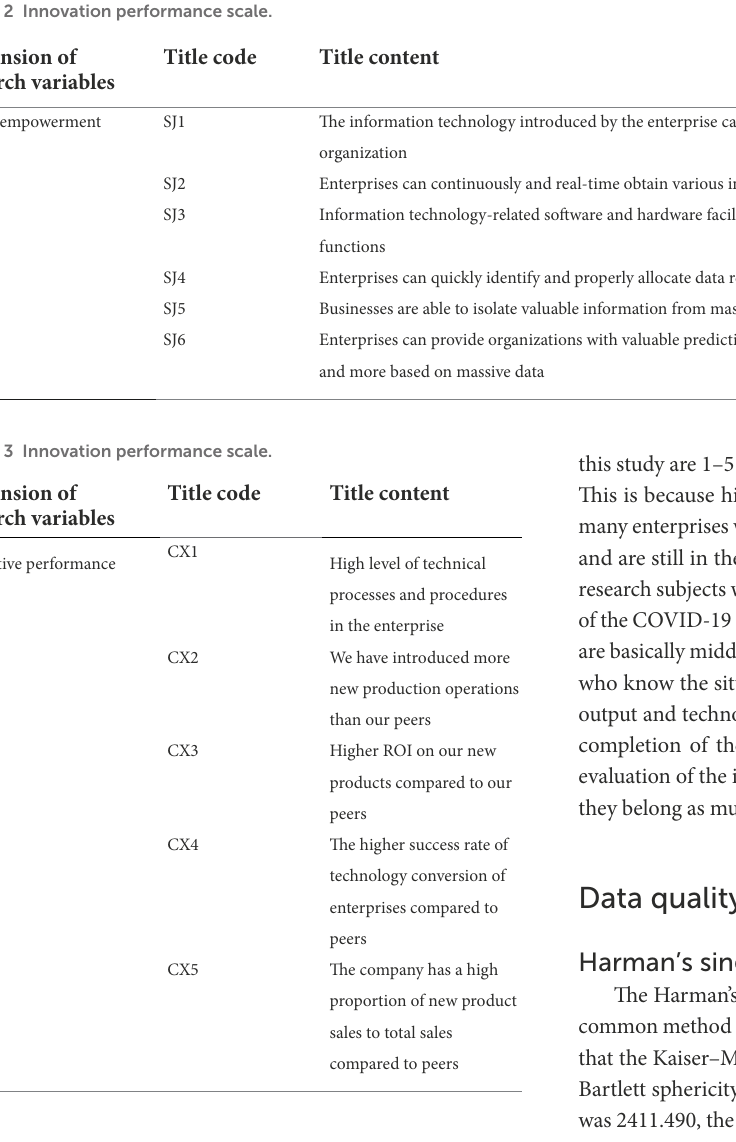
TABLE 2 Innovation performance scale.